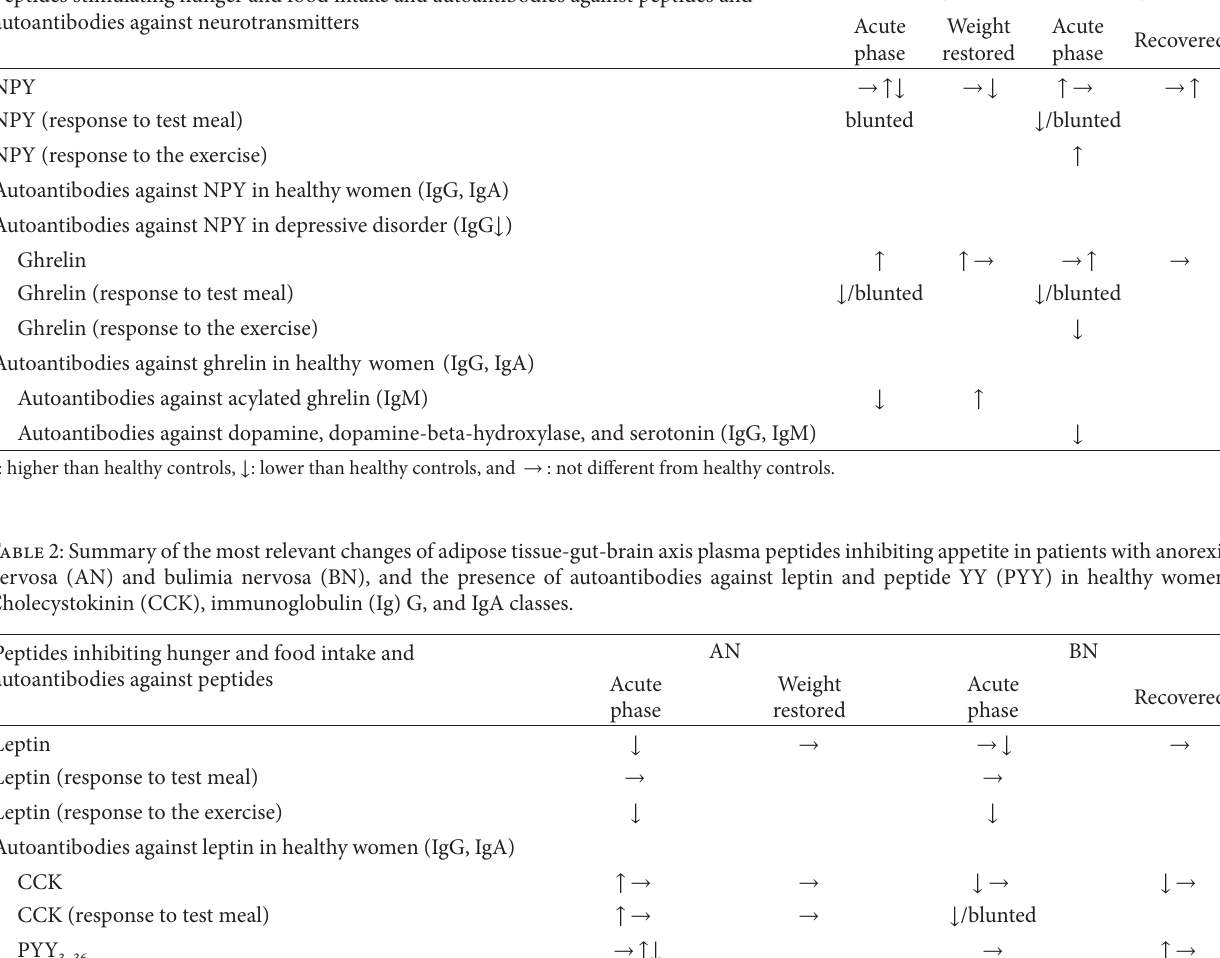
Table 1: Summary of the most relevant changes of adipose tissue-gut-brain axis plasma peptides stimulating appetite and autoantibodies against acylated ghrelin before and after refeeding in patients with anorexia nervosa (AN) and bulimia nervosa (BN), and the presence of autoantibodies against neuropeptide Y (NPY) and ghrelin in healthy women and autoantibodies against NPY in depressive disorder. Immunoglobulin (Ig) M, IgG, and IgA classes.